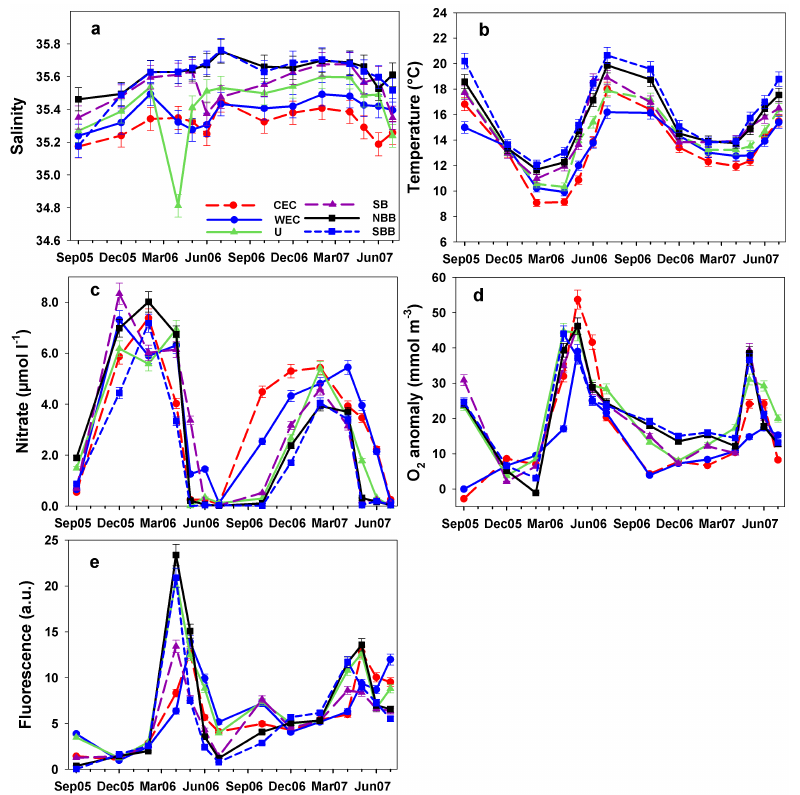
Fig. 2. Monthly mean of (a) sea surface salinity, (b) sea surface temperature ( ◦ C), (c) surface nitrate concentration (µmoll − 1 ) , (d) dissolved oxygen anomaly (mmolm − 3 ) and (e) chlorophyll a -fluorescence (arbitrary units) distribution averaged for each region: Central English Channel (dashed red line; circles); Western English Channel (blue line; circles); Ushant (green line; triangles); Shelf Break (dashed purple line; triangles); Northern Bay of Biscay (black line; squares); Southern Bay of Biscay (short dashed blue line; squares). The error bars represent the standard deviation for each mean. Data points are linearly interpolated between sampling points to allow a clear distinction of observations between regions. It should not be assumed that the interpolation provides an accurate estimate of the missing data.